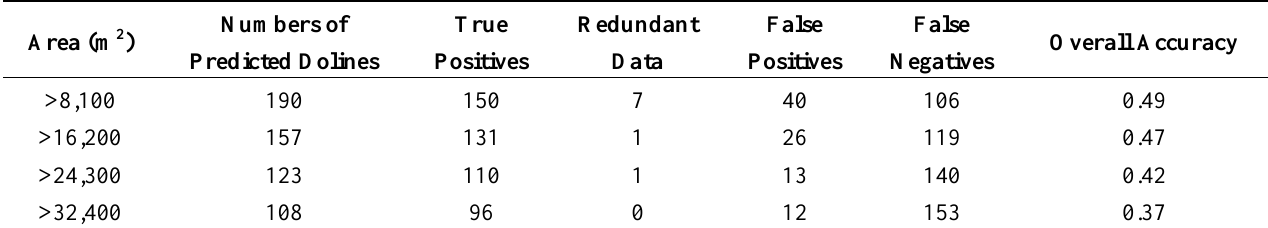
Table 4. Dolines predicted using the area attribute calculated from the doline depth > 3 m (SRTM-DEM). The comparison is made with actual dolines (249) mapped by visual interpretation.